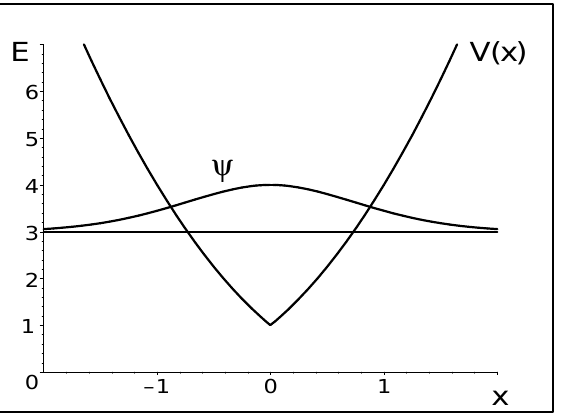
Figure 2. Ground-state energy and wave function in the single-well QES version of potential (2) at d = − µ = −